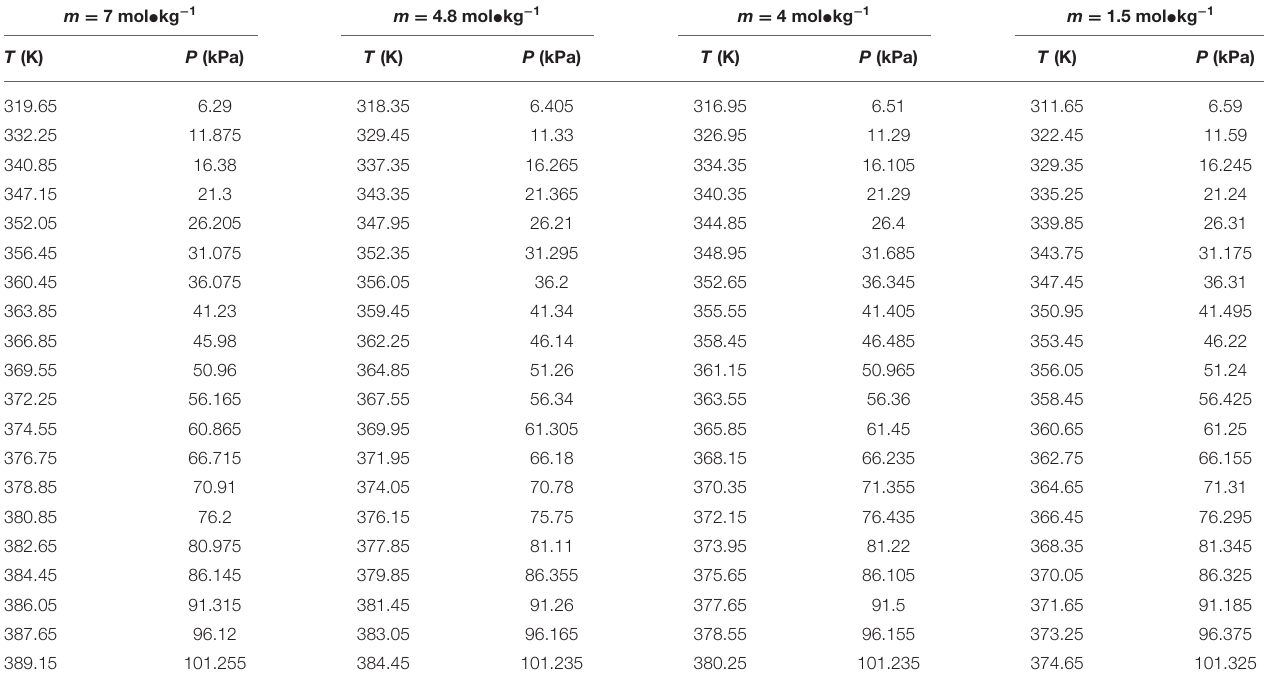
TABLE 3 | Experimental VLE data for temperature T , pressure P , and molality m— LiBr for the LiBr + H 2 O system.